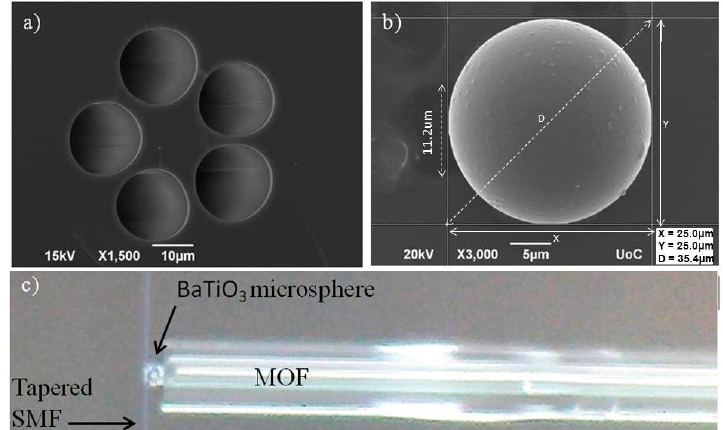
Figure 1. ( a ) Scanning electron microscope (SEM) picture of the un-tapered, grapefruit shaped micro-structured optical fiber (MOF) used, with five air capillaries and germanium doped core, ( b ) SEM image of the attached BaTiO 3 , microsphere with 25 μ m diameter, top fitting in one of the capillaries (diameter: 11.2 μ m) of the tapered MOF. The other empty capillaries can be seen in the background, ( c ) optical microscope picture of a side view on the T-shaped light coupling system (single mode optical fiber taper (SOFT) placed perpendicular to MOF in a contact with the microsphere).